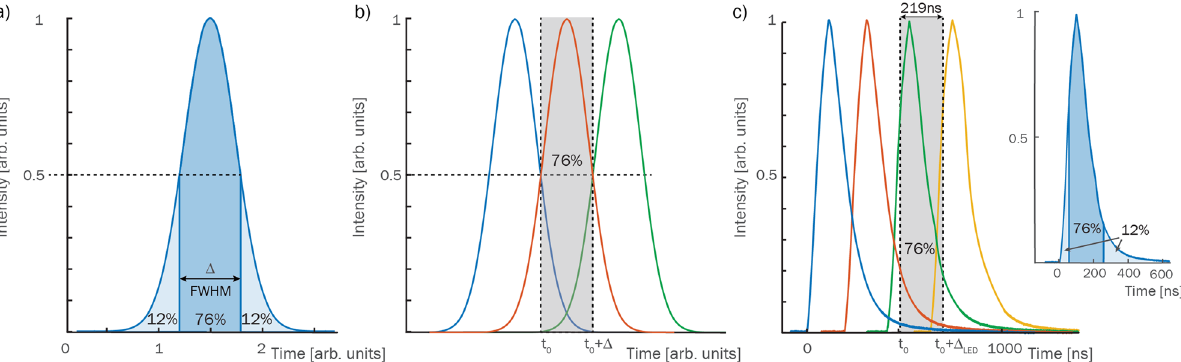
Figure 4. Temporal resolution of an imaging system. ( a ) A Gaussian gate profile has 76% of its